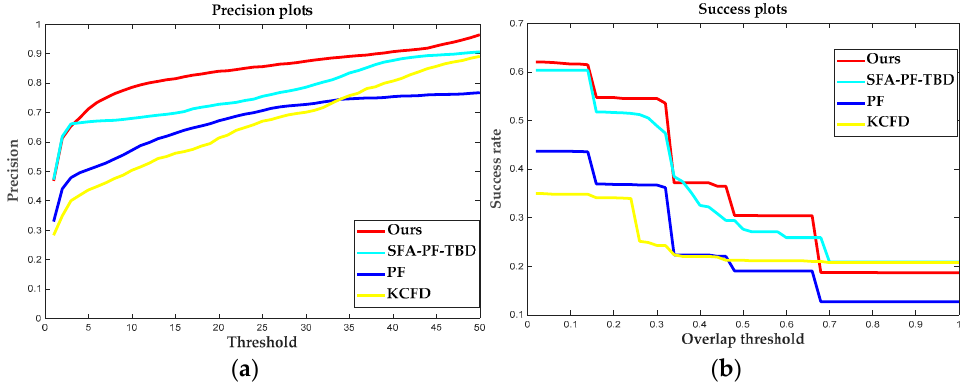
Figure 7. Average distance accuracy plot and success rate plot of four algorithms in six groups of sequences. ( a ) Precision plots and ( b ) success plots. Table 2. Average center pixel error, 20-pixel distance accuracy, overlap rate, and running speeds of the four algorithms.